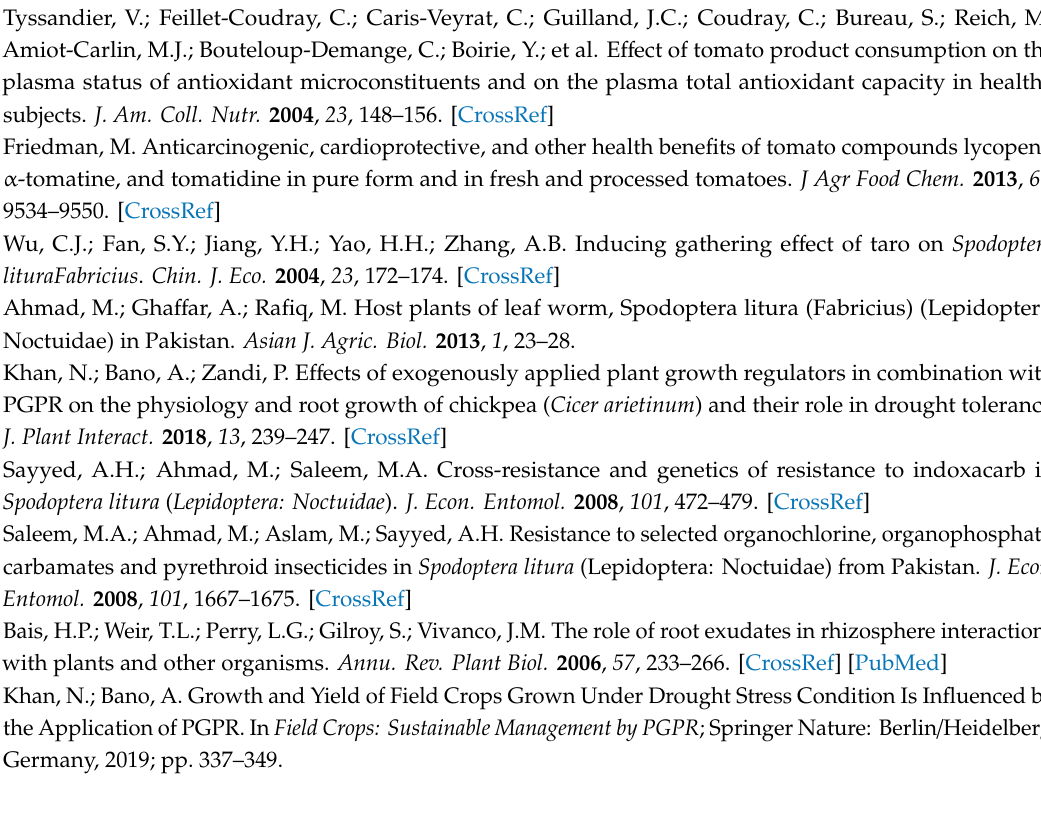
Table S1: Results of the statistical analysis (ANOVA) for the performed